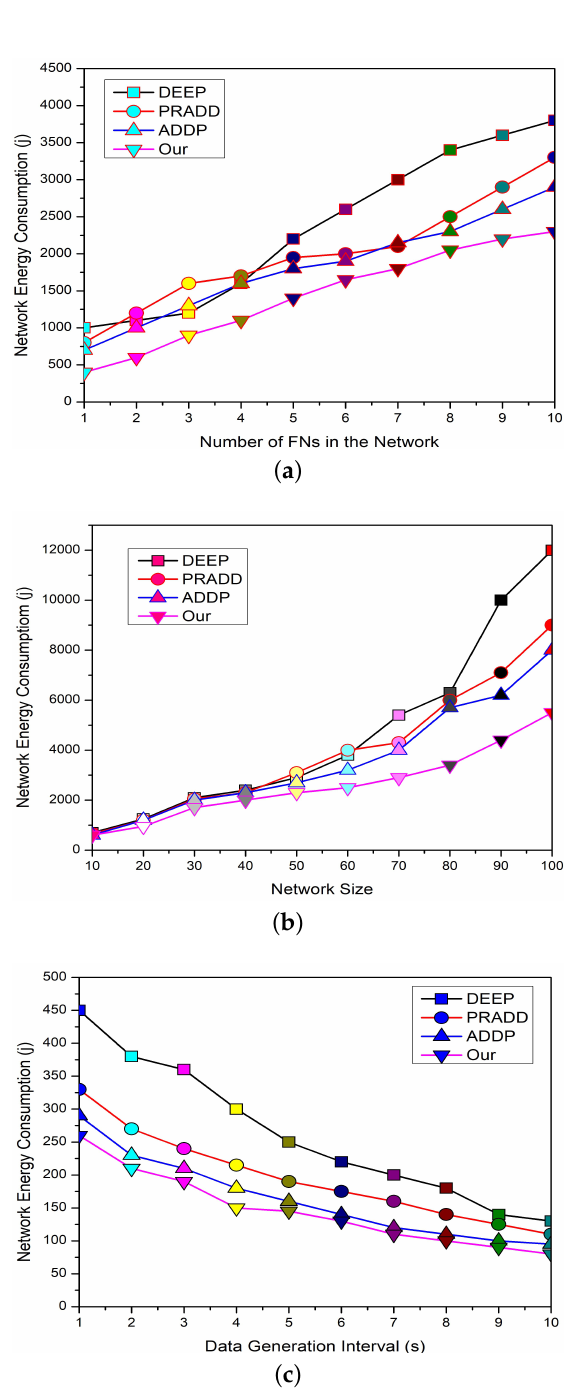
Figure 9. The effect of number of field nodes, network size, and data generation interval on the network energy consumption of the proposed